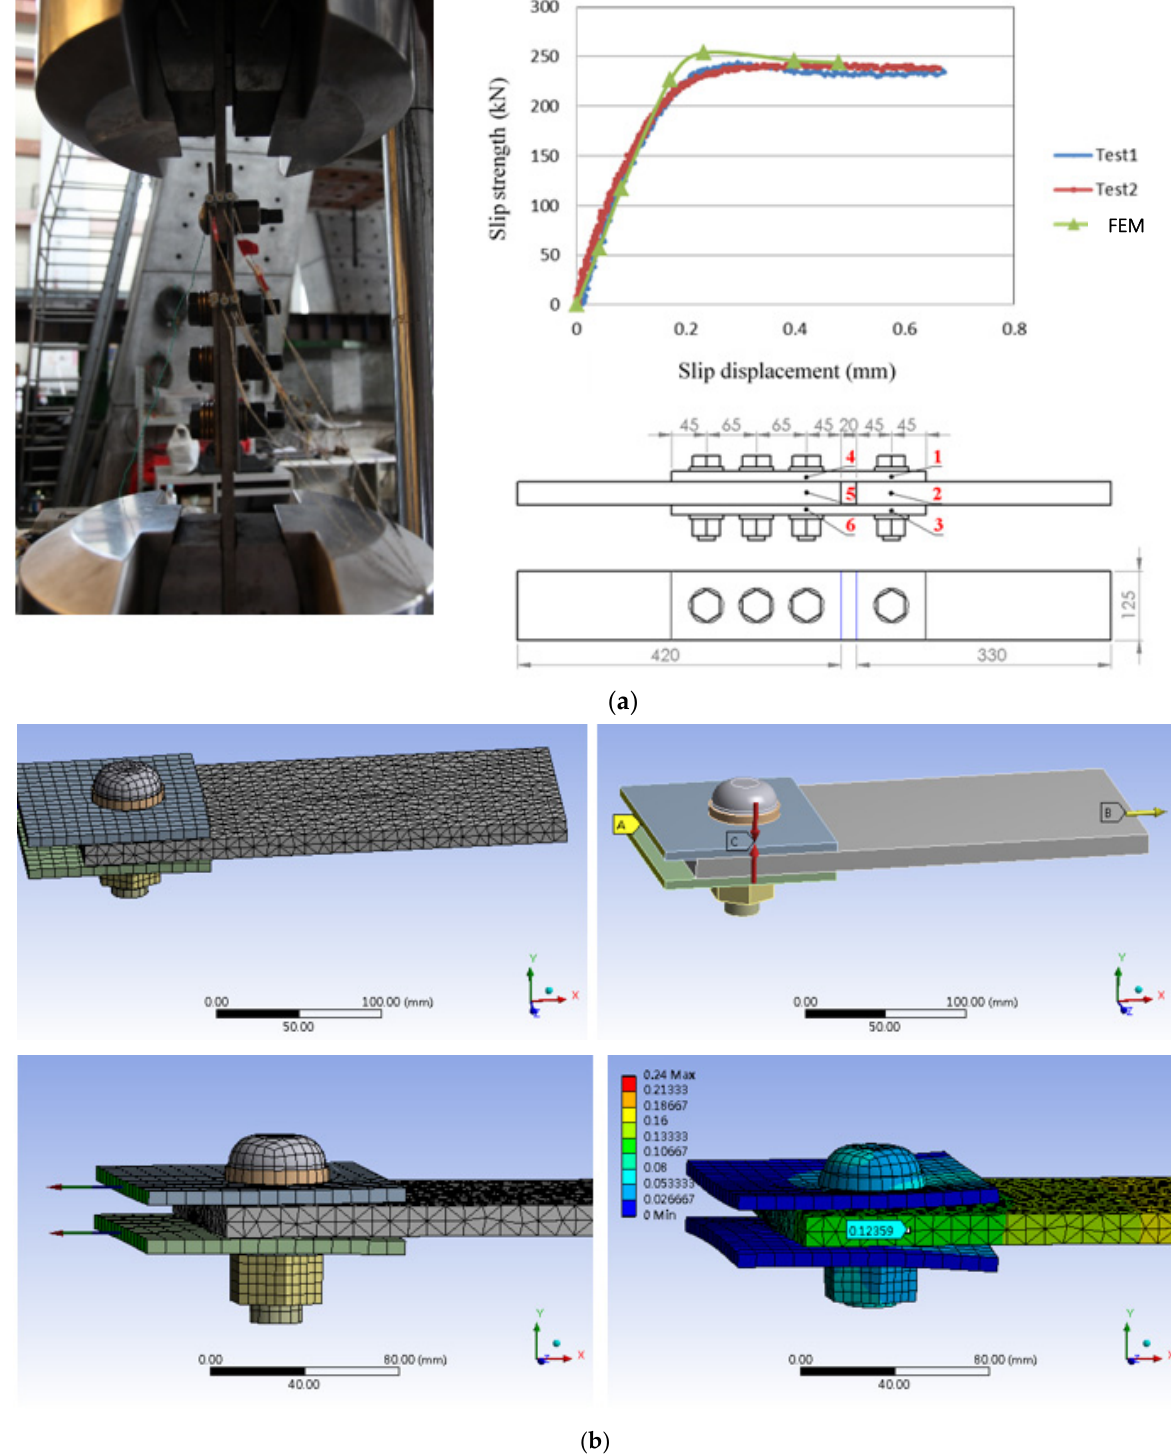
Figure 2. FEM simulation of bolt slippage; ( a ) model validation, ( b ) FEM simulation.